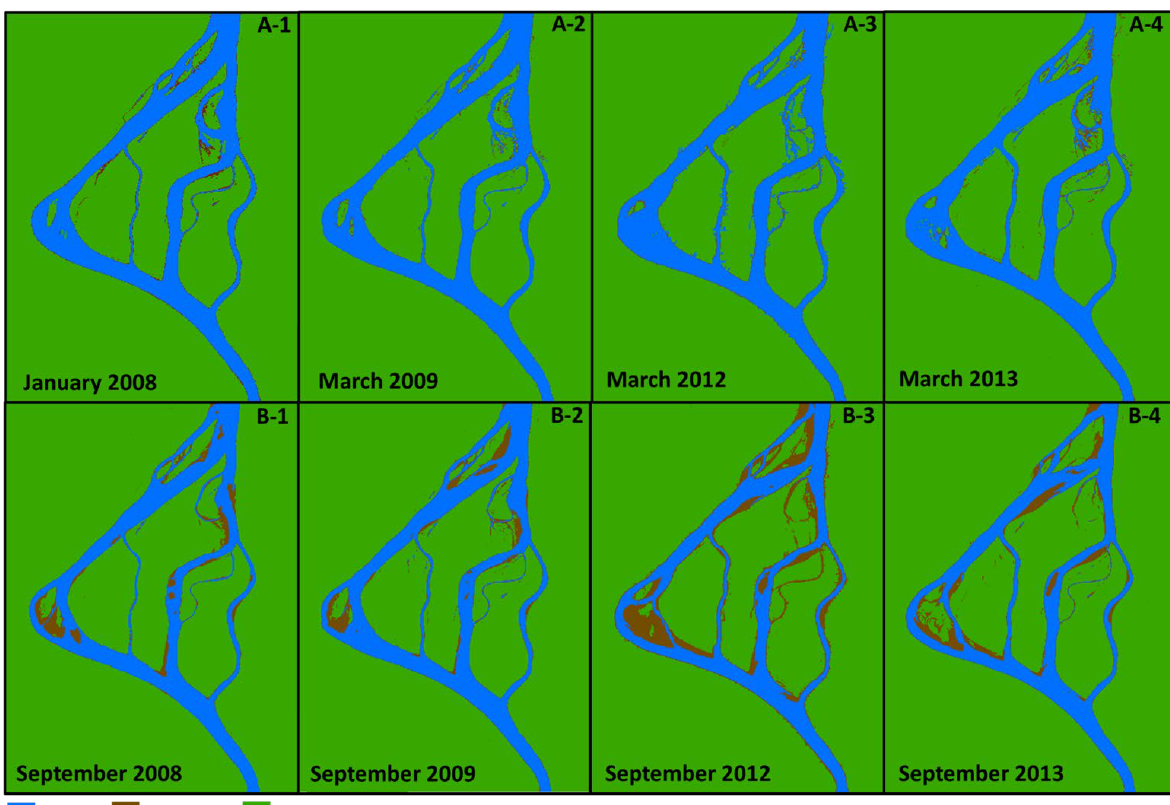
Figure 5. Land cover classification of the Muyuy anabranching structure in the upper Peruvian Amazon (water: blue, brown: bare soil, and green: vegetation and others) in 2008–2013. Series images A-1, A-2, A-3 and A-4 represent the wet season (January–March), and series images: B-1, B-2, B-3 and B-4 represent the dry season (September).